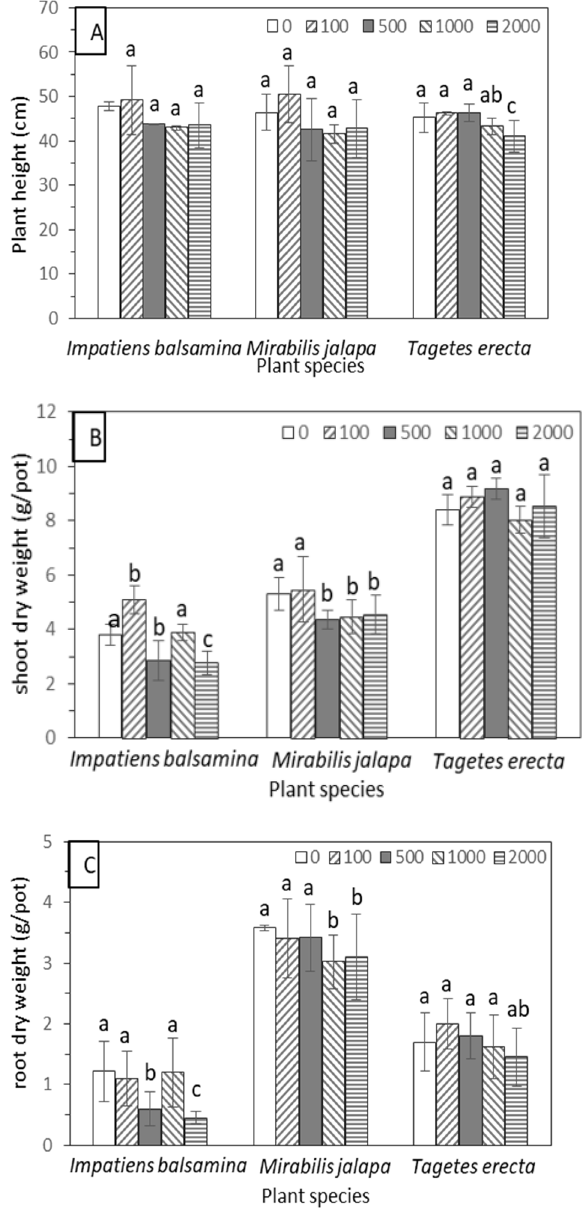
Figure 1. Sn tolerance under soil culture conditions for three ornamental plants: ( A ) stem length under different Sn treatments; ( B ) shoot biomass (dry weight) under different Sn treatments; ( C ) root biomass (dry weight) under different Sn treatments. Bar diagrams in the same column followed by the same letter are not significantly different, whereas those with different letters indicate significant differences ( p < 0.05). Bars indicate standard errors (n = 3).